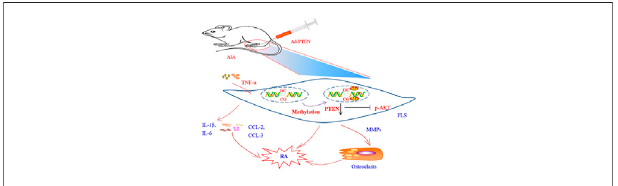
FIGURE 7 | PTEN methylation promotes in fl ammation and FLS activation in RA. Methylation-induced downregulation of PTEN promotes in fl ammation and activation of FLS in the development of RA via the proin fl ammatoryfactorsIL-1 β ,IL-6,CCL-2,andCCL3.TNF- α produced by in fl ammatory cells (eg., macrophages and T cells) induces the activation of FLS and aggravates cartilage destruction. Overexpression of PTEN reversed these pathologic